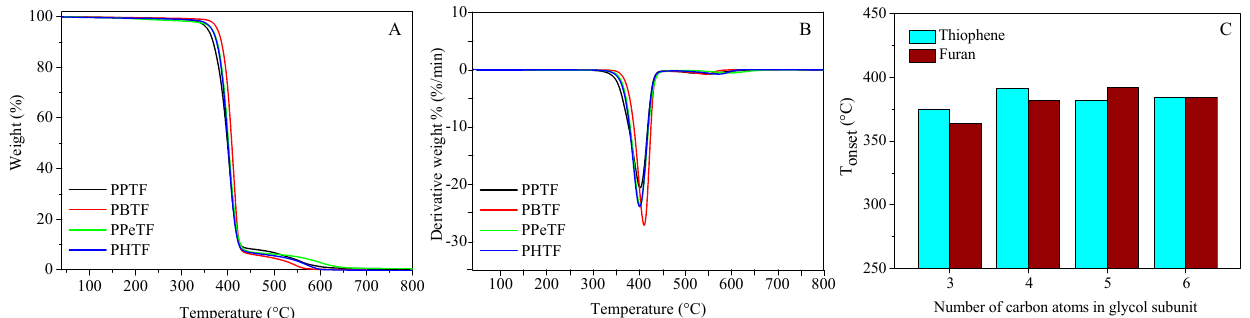
Table 2. Thermal characterisation (TGA and DSC) data of the homopolymers under study in the form of compression- moulded